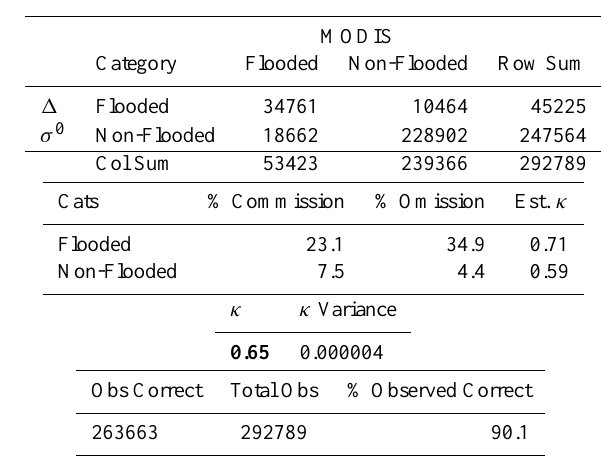
Table 2. Error matrix and κ statistic for the flood map on 29 August 2010 when compared with MODIS flood